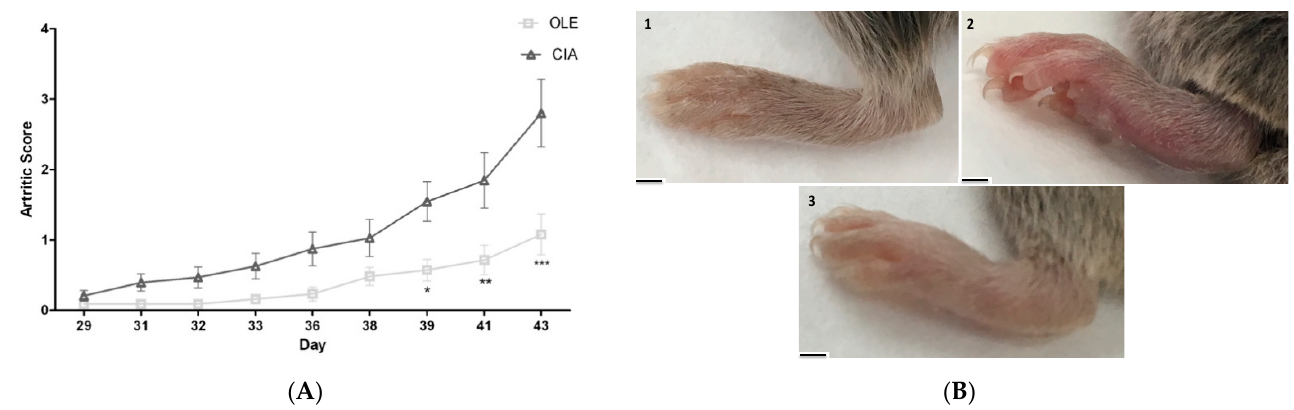
Figure 1. Evolution of arthritis severity in collagen-induced arthritis (CIA) mice from day 29 to 43 after second immunization. ( A ) Changes in paw swelling and thickness on arthritic mice. Sings was scored every two days up to the end of experiment. CIA control group, collagen-induced arthritis mice fed with standard diet (SD); OLE, arthritic mice fed with 0.025% w/w oleocanthal-supplemented diet. Values are presented as mean ± S.E.M. ( n = 10). * p < 0.05; ** p < 0.01; *** p < 0.001 vs. CIA group. ( B ) Image of hind paws at the end of experiment (Day 43): Naïve group, non-arthritic mouse fed with SD; CIA control group with SD; and, OLE supplemented diet arthritic group. Scale bar = 1 cm (1–3).